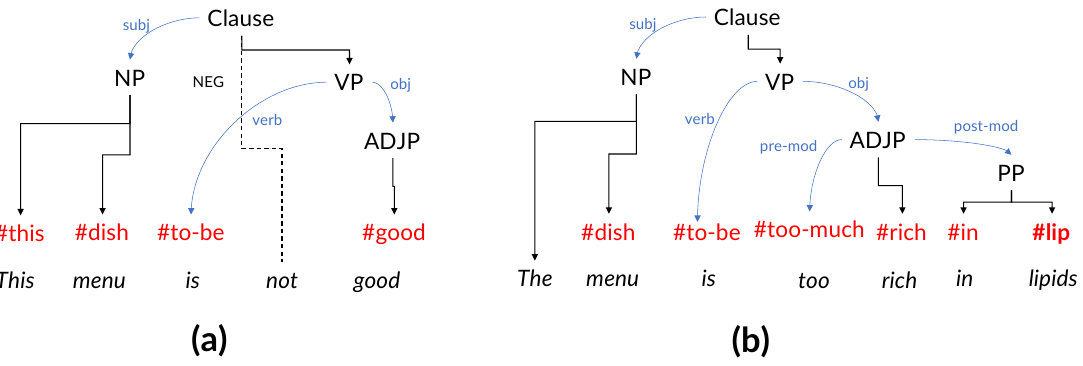
Figure 4. The sentence generated by the quasi-tree ( a ) expresses the overall evaluation on the selected menu, and the sentence generated by the quasi-tree ( b ) expresses the specific appropriateness of the macronutrient. NP, noun phrase; VP, verbal phrase; ADJP, adjectival phrase; PP, prepositional